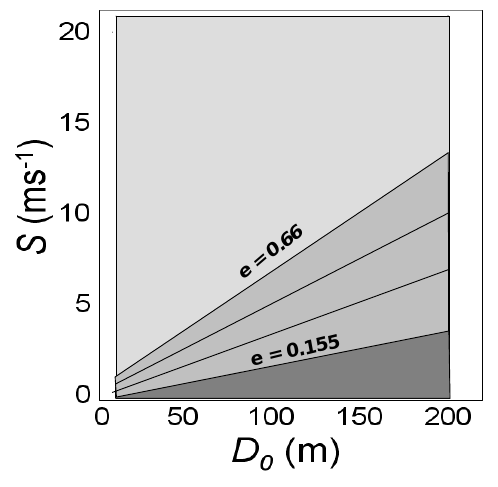
Figure 4. Entrainment coefficient as a function of transport wind speed and initial plume diameter.